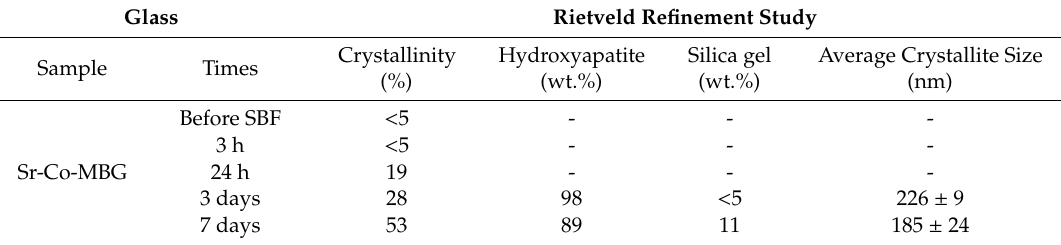
Table 5. Summary of the results of Rietveld refinement study for Sr-Co-MBG.